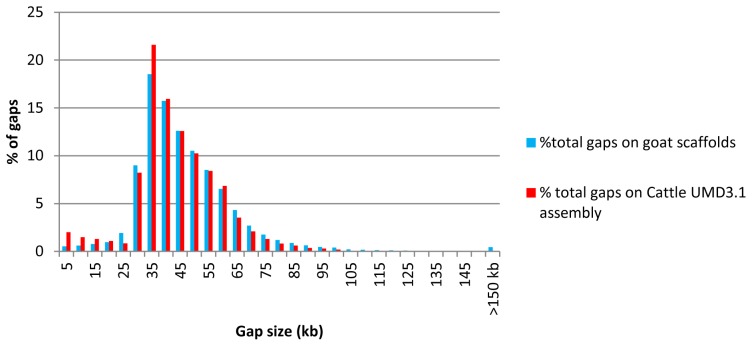
SNP spacing on the goat scaffolds.Spacing between the selected SNPs was calculated and the percentage of gaps (total number of gaps is 59,030 on goat scaffolds and 62,693 on UMD3.1 cattle assembly) is shown (y-axis) in each 5kb class ranging from 5 to 150kb (x-axis).